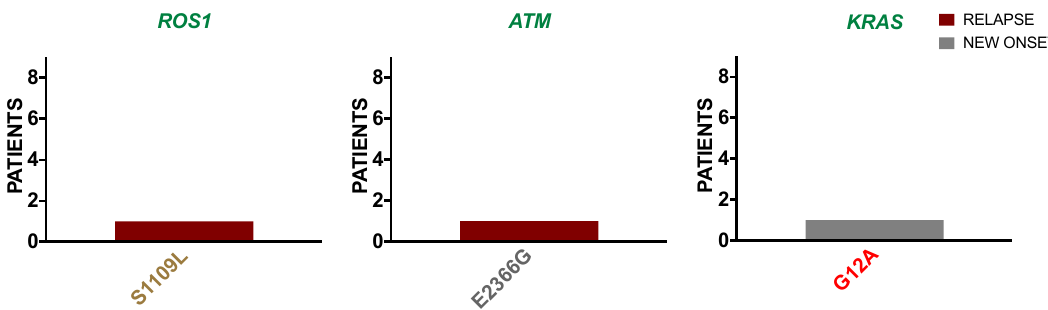
Figure 1. ALL borderland patients harbor tier mutations detected in first level cancer biomarkers with therapeutic potential. Variants are shown occurring in new-onset (grey) and relapse (maroon) ALL patients where mutational significance is indicated by Tier 1 (red), Tier 3 (gold), and Tier X (grey) within Level 1 clinically relevant genes (green) including ROS1 , ATM , and KRAS